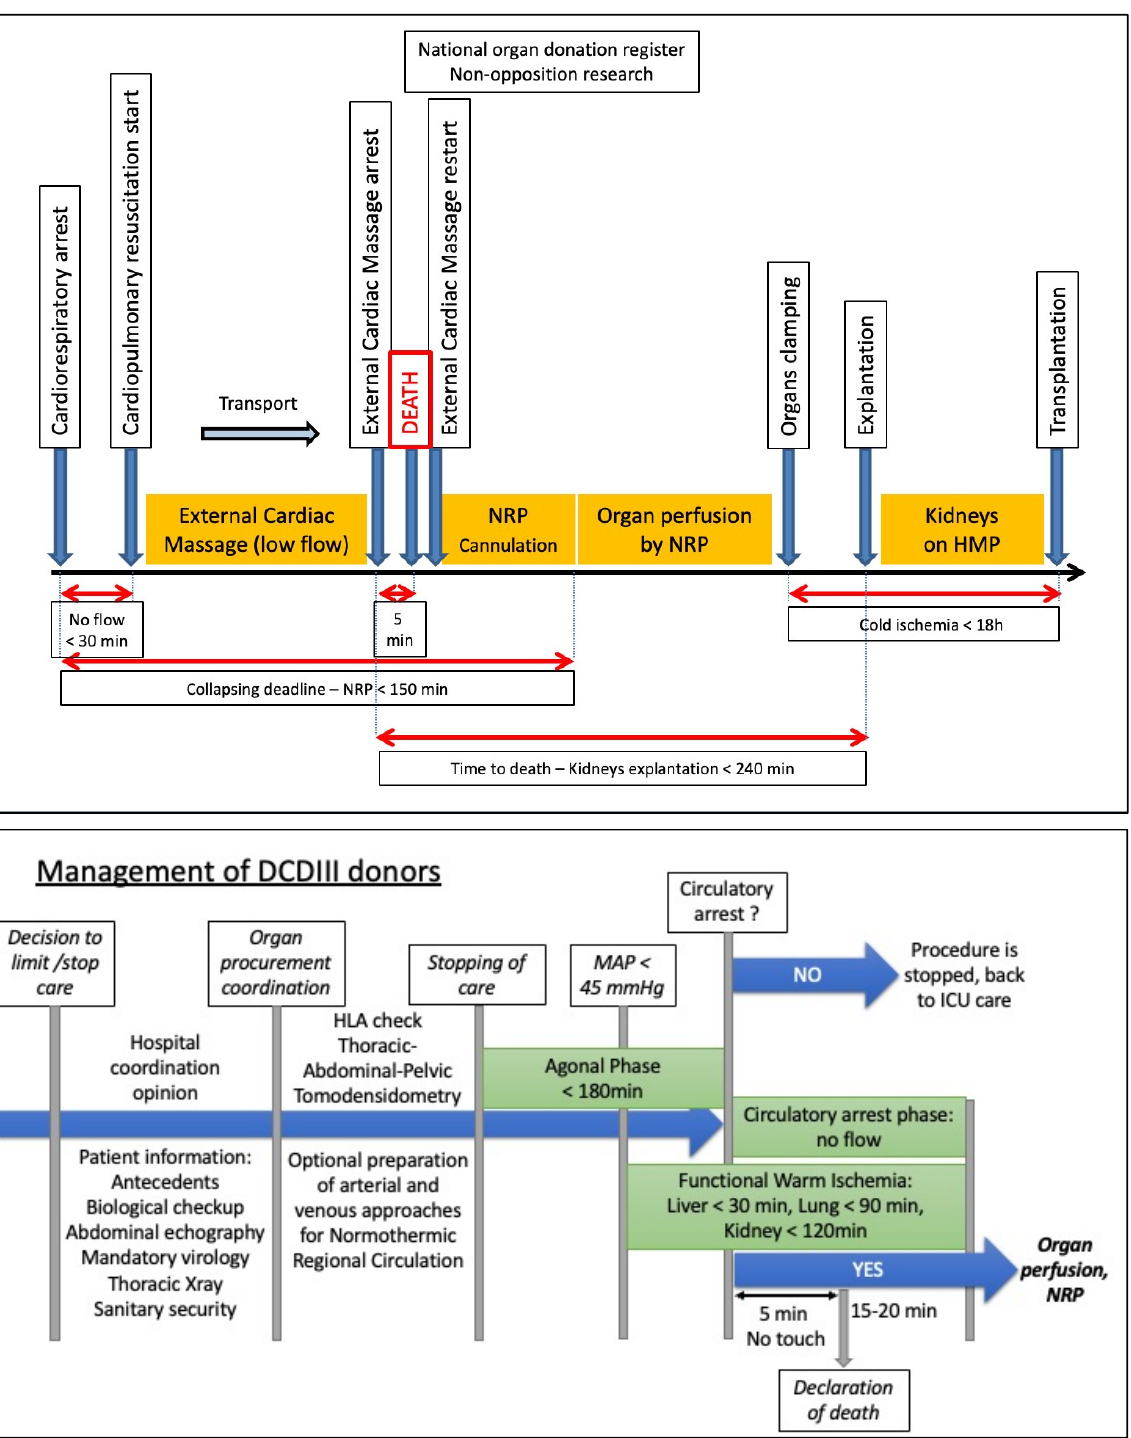
Figure 3. Management protocols for DCDs. Top: organization and timeframes for organ retrieval using NRP from donors who have died after circulatory arrest (NRP—normothermic regional perfusion; HMP—hypothermic machine perfusion; MAP—mean arterial pressure). Figure from the French Association of Urology [13]. Bottom: management of Maastricht III donors. NRP—normothermic regional perfusion. Figure adapted from the Agence de Biomedecine.